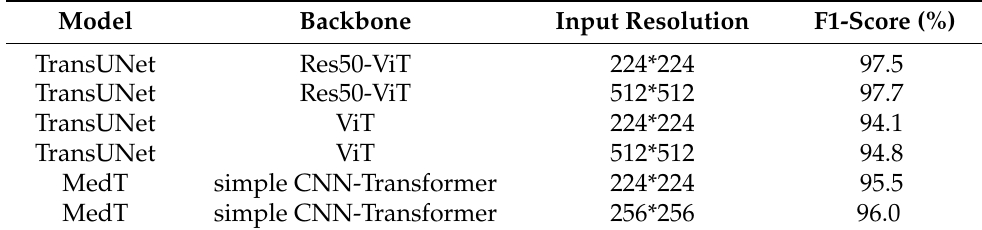
Table 2. Quantitative results of TransUNet and MedT on CorsicanFire dataset